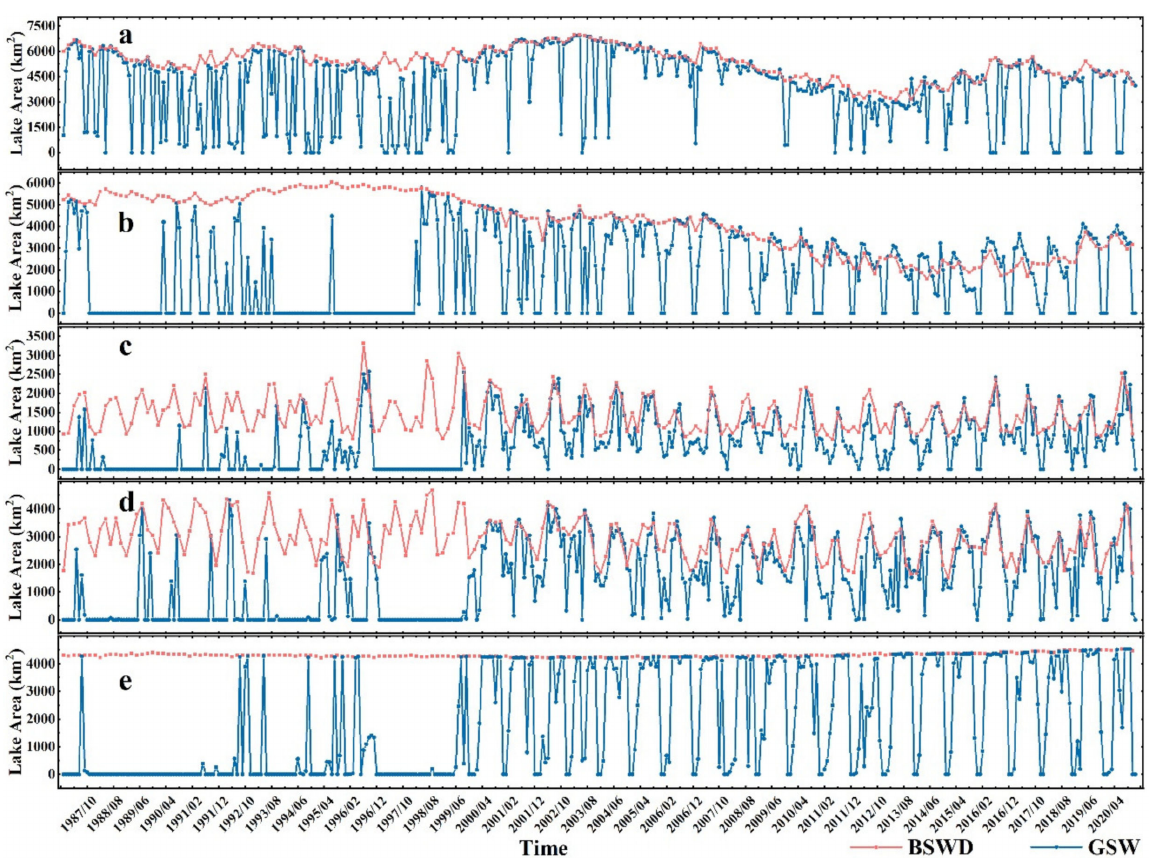
Figure 10. Comparison of BSWD with GSW monthly data. ( a ) Chiquita Lake; ( b ) Urmia Lake; ( c ) Dongting Lake; ( d ) Poyang Lake; and ( e ) Qinghai